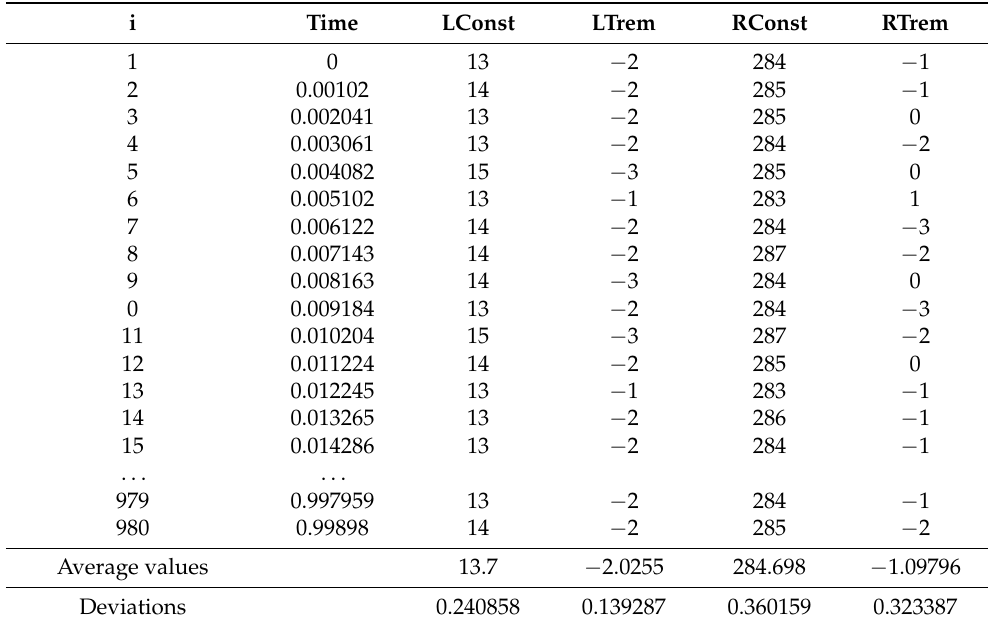
Table 1. Measurement results with constant pressure on the right-hand support element of the strain gauge measuring